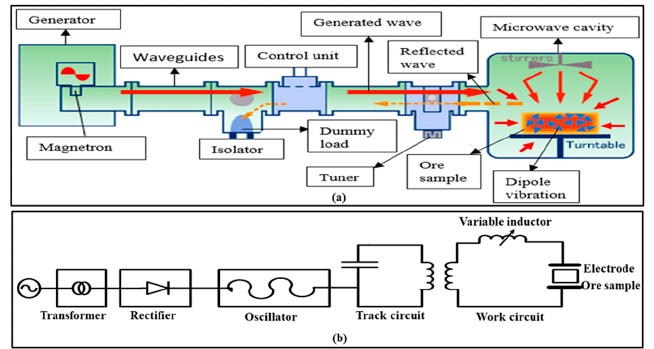
Figure 6. ( a ) Ore pretreatment in a microwave oven (modified after [50]). ( b ) Ore pretreatment in a radiofrequency device [51].